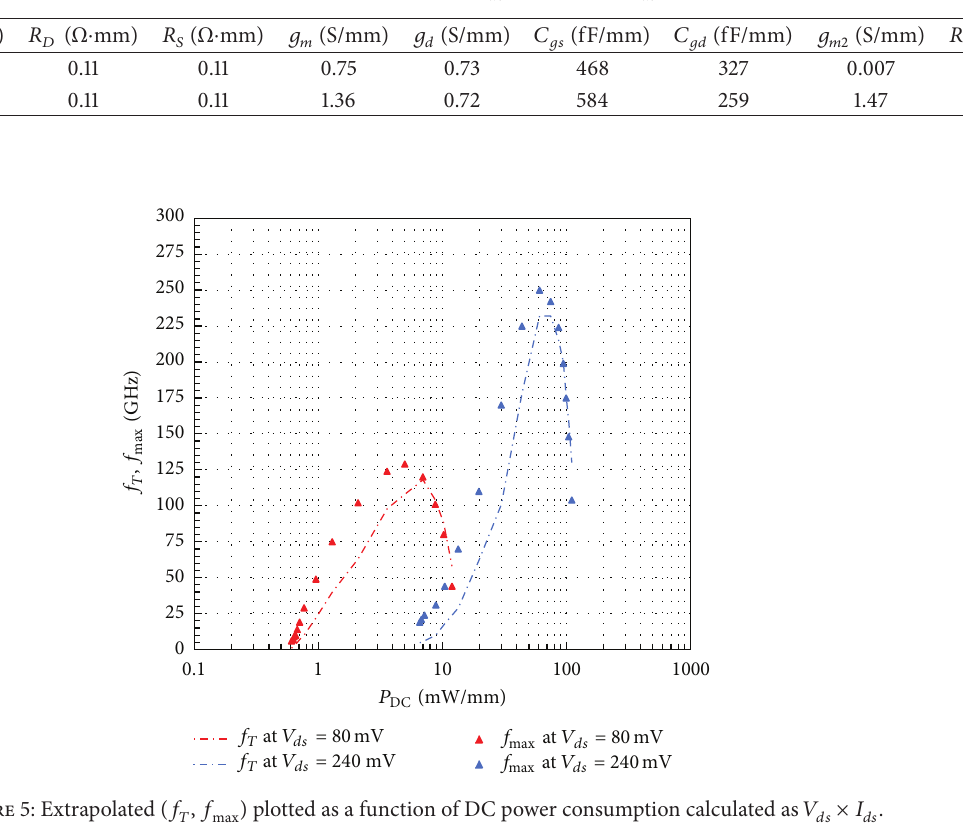
Table 1: Small-signal equivalent circuit parameters for 𝑉 𝑑𝑠 = 80 mV and 𝑉 𝑑𝑠 = 240 mv at peak 𝑓 𝑇 .